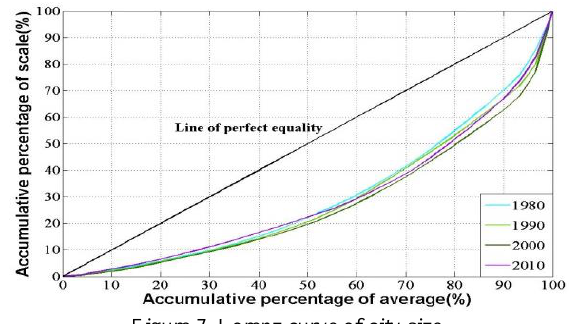
Figure 7. Lorenz curve of city